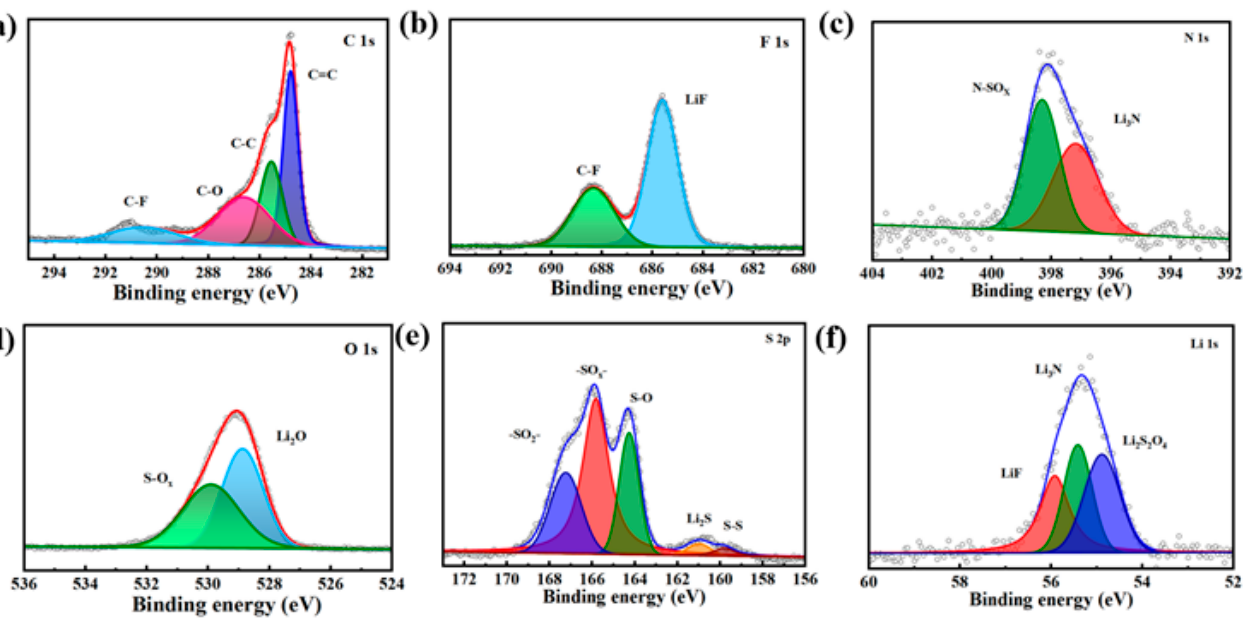
Figure 10. XPS analysis of graphite anode after three cycles in LHCE electrolyte: ( a ) C 1s, ( b ) F 1s, ( c ) N 1s, ( d ) O 1s, ( e ) S 2p, ( f ) Li 1s.